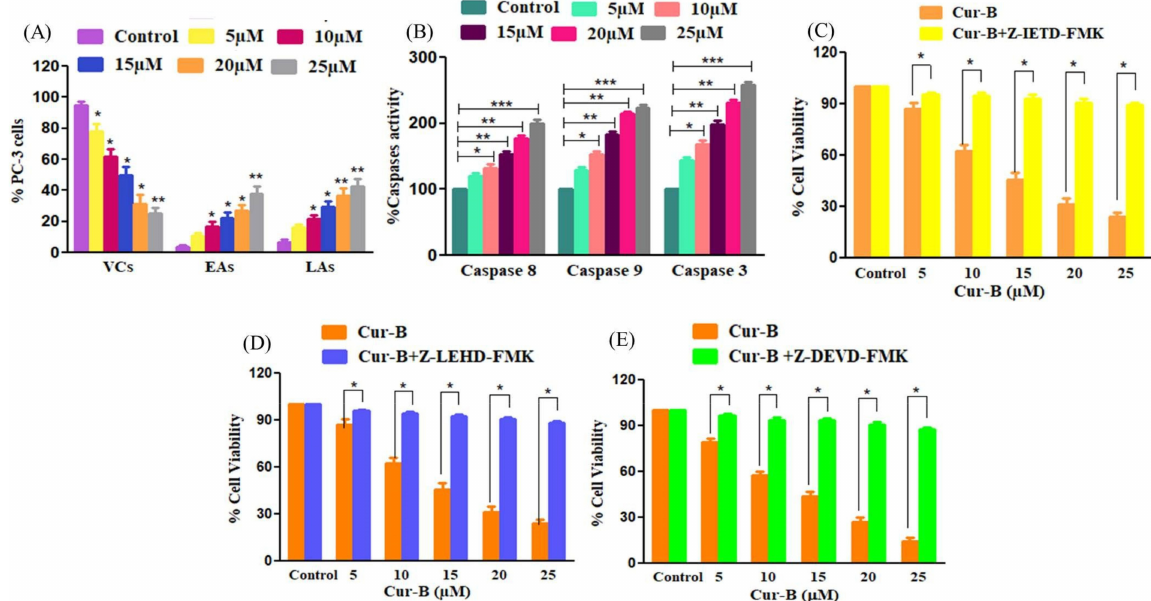
Figure 5. Quantification of Cur-B-instigated ( A ) apoptosis, ( B ) Cur-B mediated activation of caspase-8, -9 and -3 and ( C – E ) cytotoxic effects of Cur-B against caspase inhibitor pretreated PC-3 cells. VCs, viable cells; LAs, late apoptotic cells; EAs early apoptotic cells. * p < 0.05, ** p < 0.01, *** p <